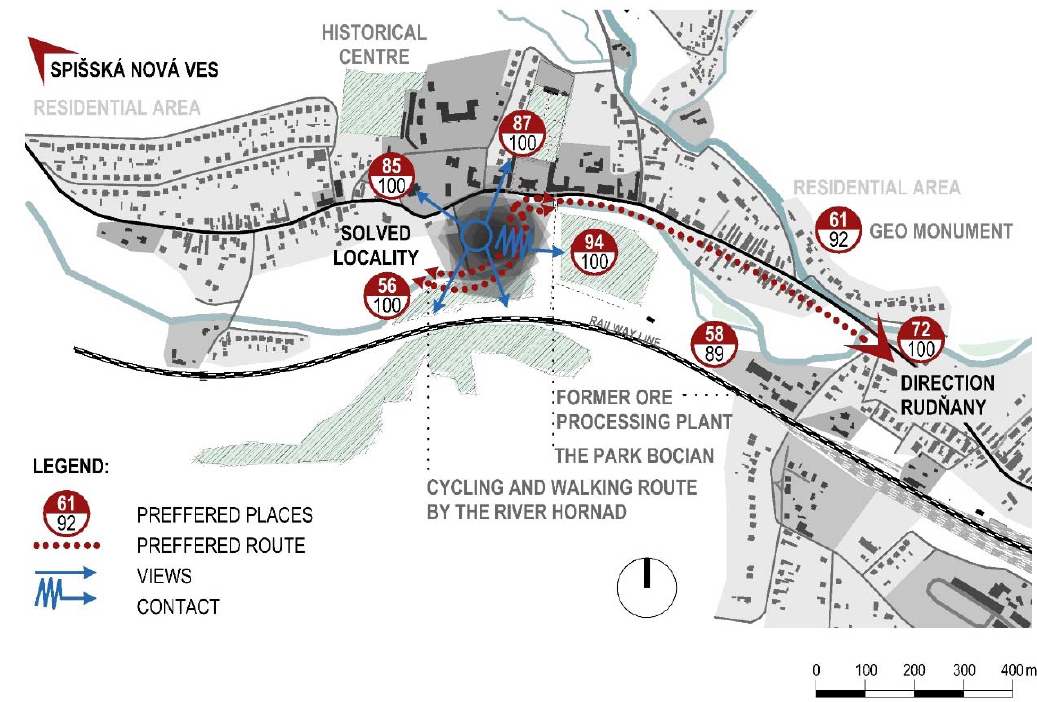
Figure 9. The emotional map of the solved locality—Markušovce. (In the circle—the number of respondents out of 100).